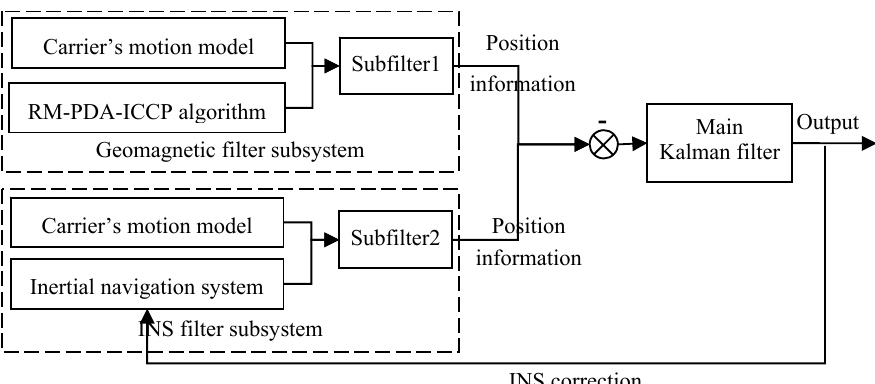
Figure 5. Inertial/geomagnetic integrated navigation system. Figure 5. Inertial / geomagnetic integrated navigation